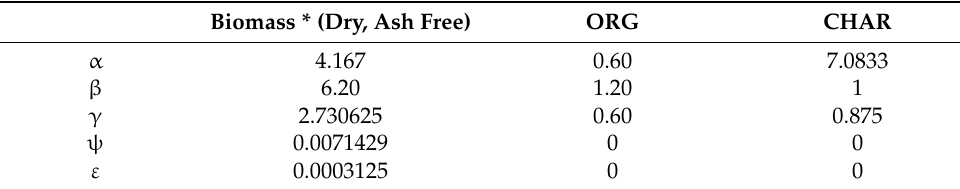
Table 1. Values of coefficients α , β , γ , ψ , and ε .